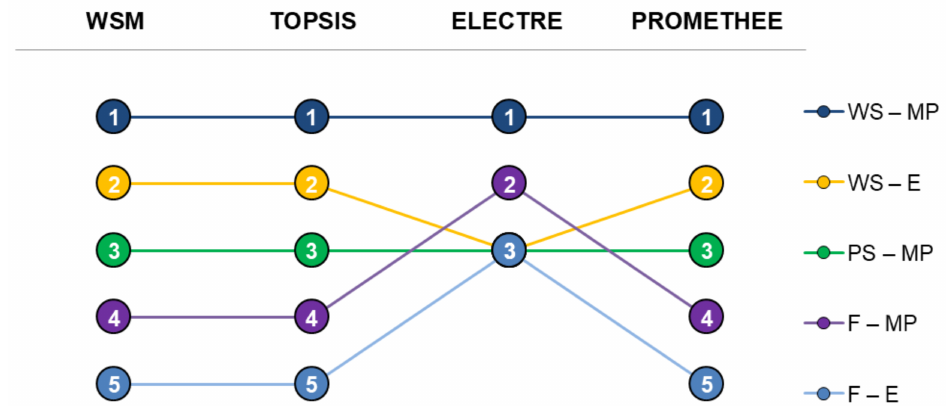
Figure 2. Ranking (equal weighted) of wood-based residential heating alternatives obtained through application of: (i) WSM, (ii) TOPSIS, (iii) ELECTRE, and (iv)